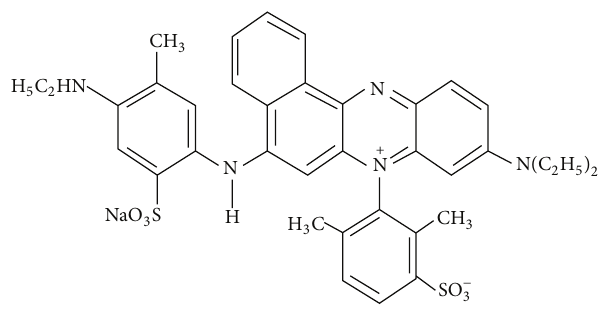
Figure 1: The molecular structure of TB AGLF. Table 2: Some essential properties of TB